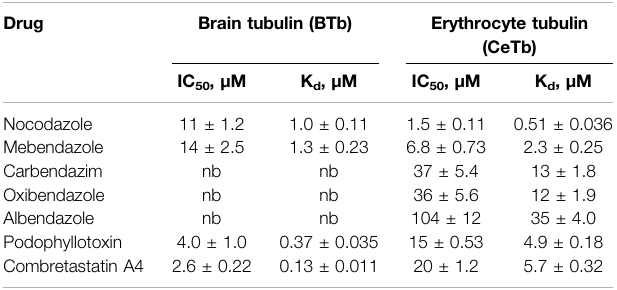
TABLE 3 | Dissociation constants of tubulin — benzimidazoles-, podophyllotoxin-, and combretastatin A4 - interaction measured by competition titration with MDL.